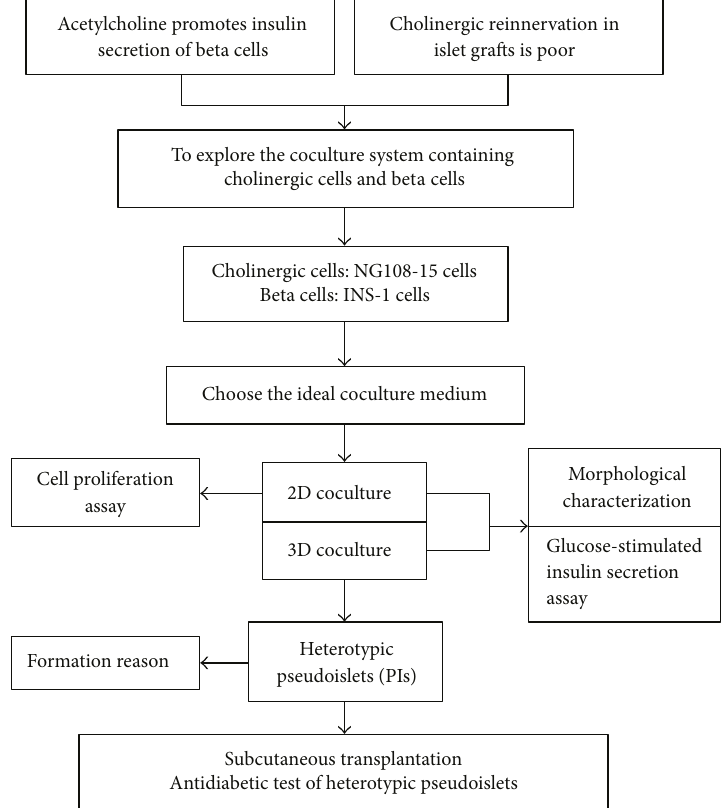
Figure 1: A fl owchart of the study